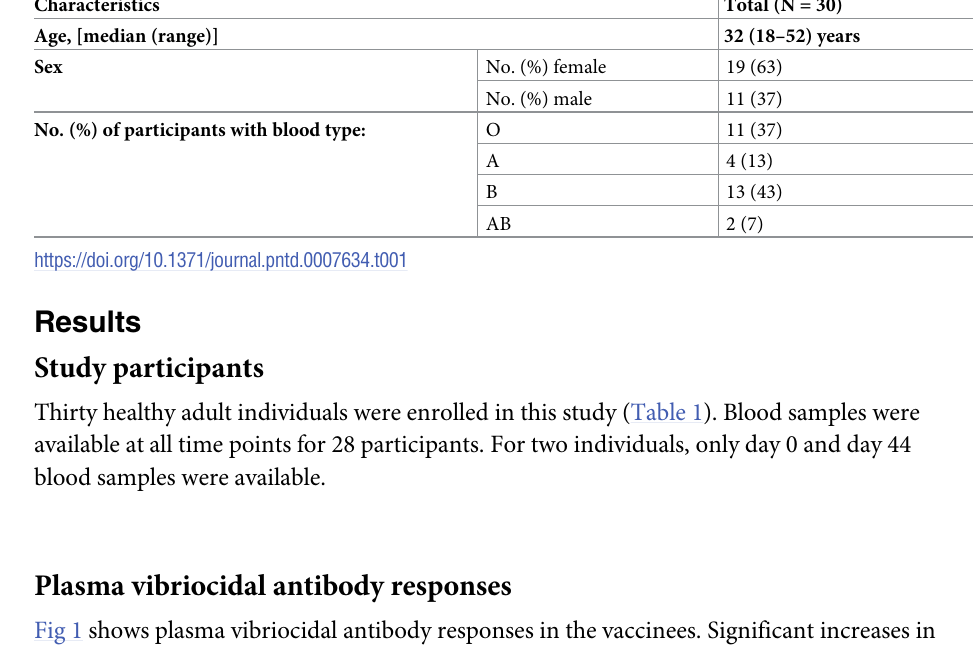
Table 1. Demographic characteristics of study participants.